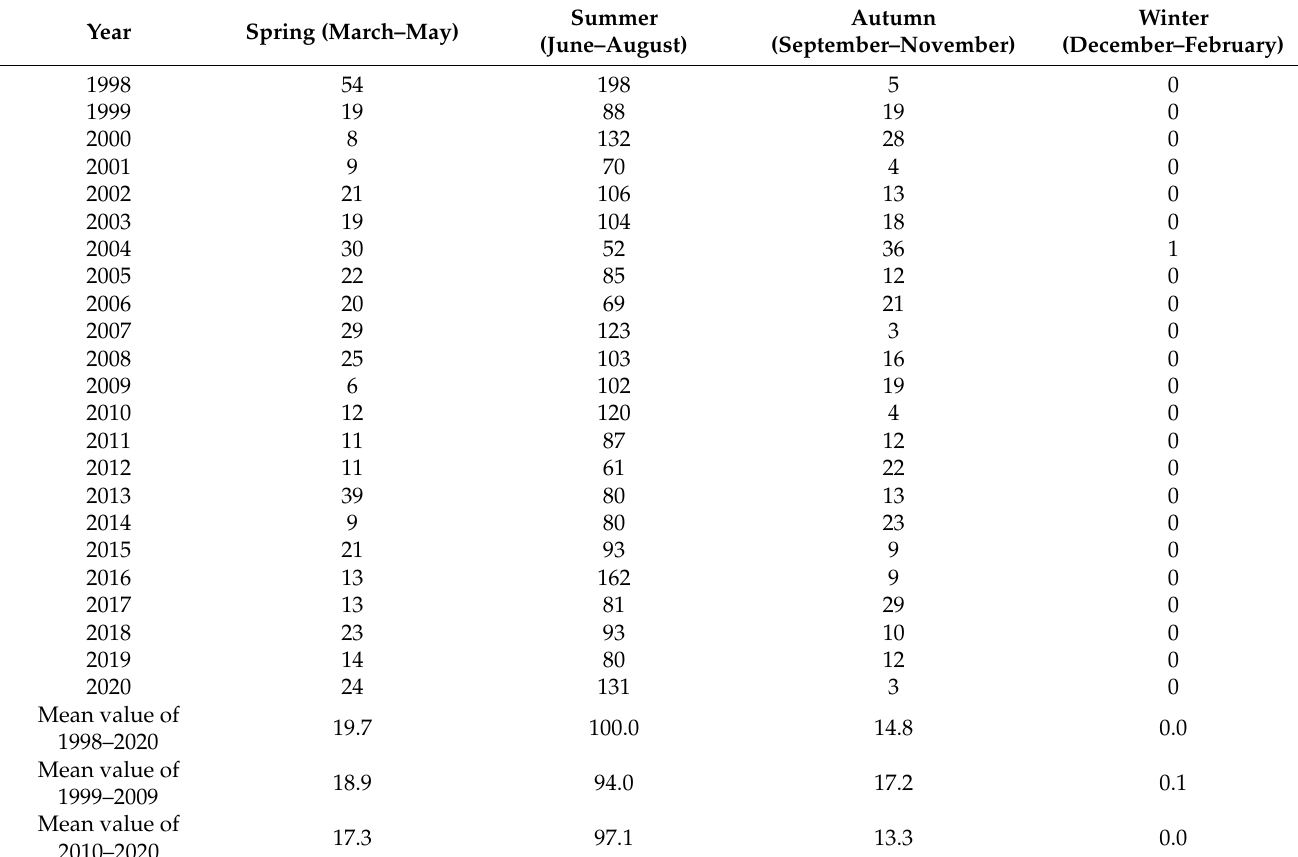
Table 4. Statistical table of frequency of hourly heavy precipitation ( ≥ 20 mm/h) in each season from 1998 to